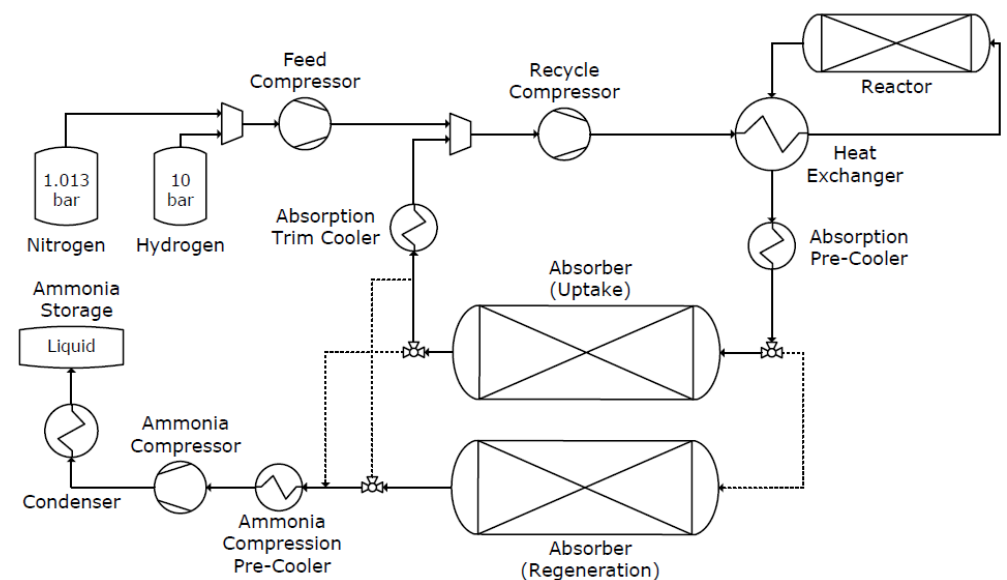
Figure 1. Absorbent-enhanced ammonia synthesis process flow